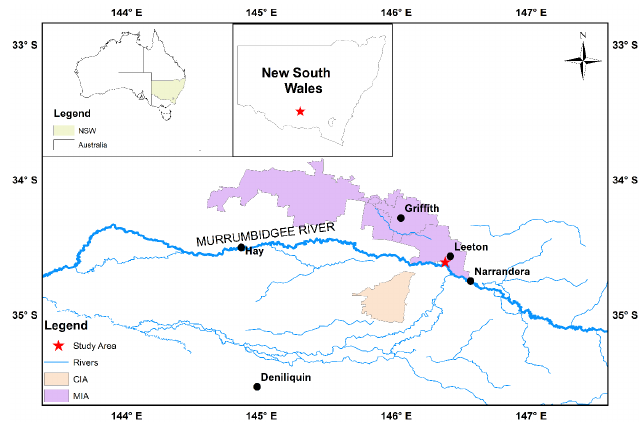
Figure 1. Map of study site of Leeton, New South Wales, Australia. CIA (Coleambally Irrigation Area) and MIA (Murrumbidgee Irrigation Area) refer to locally important irrigation areas.